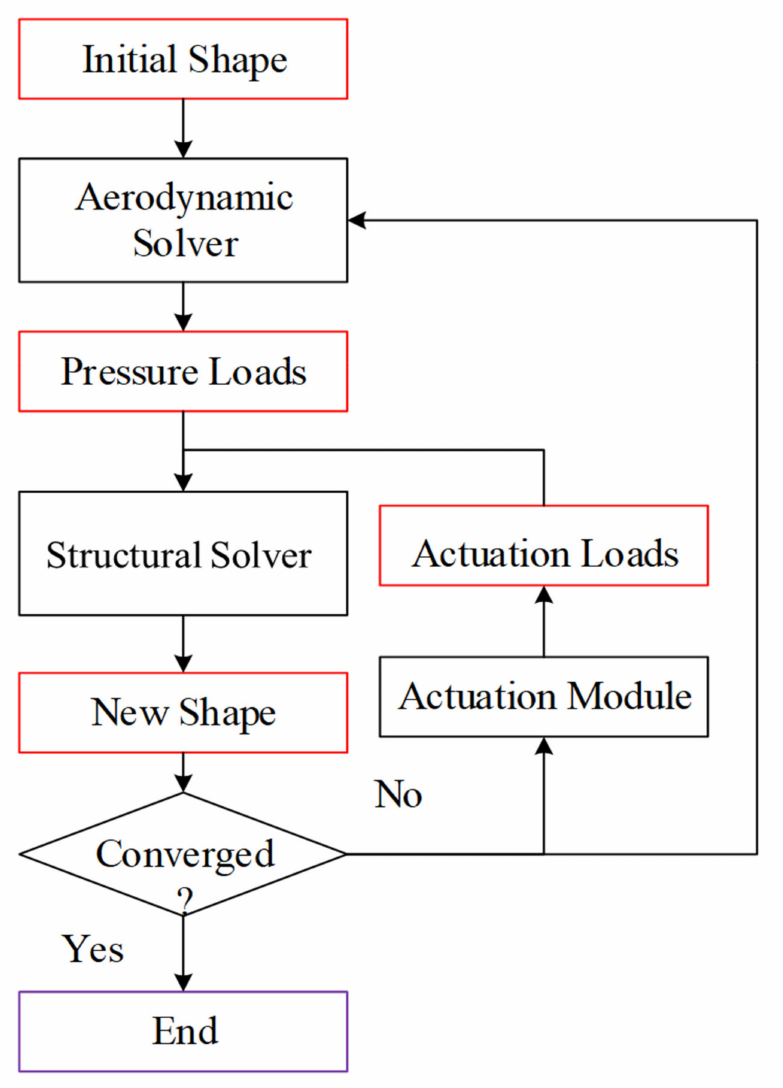
Figure 10. Static aeroelastic analysis algorithm